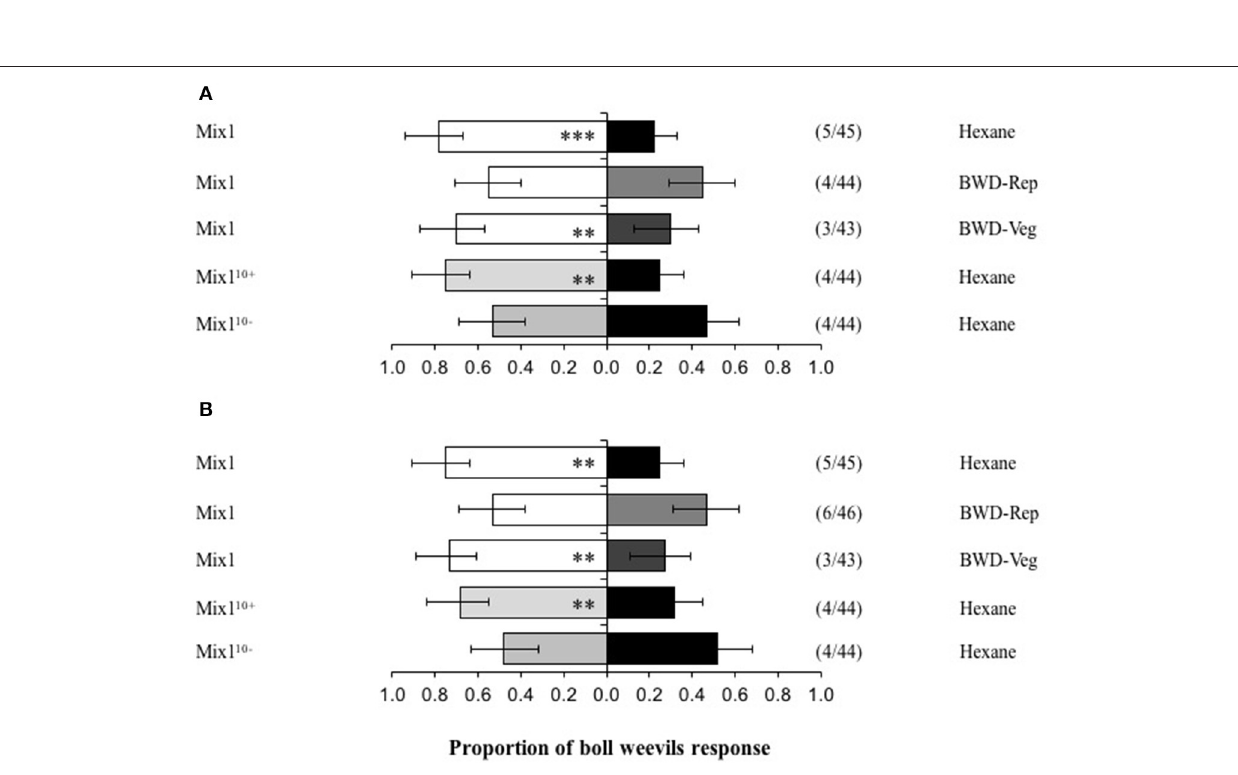
Frontiers in Ecology and Evolution |